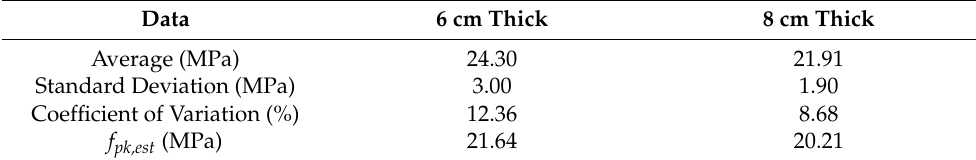
Table 9. Results of compressive strength obtained for concrete pieces of 6 and 8 cm thickness.